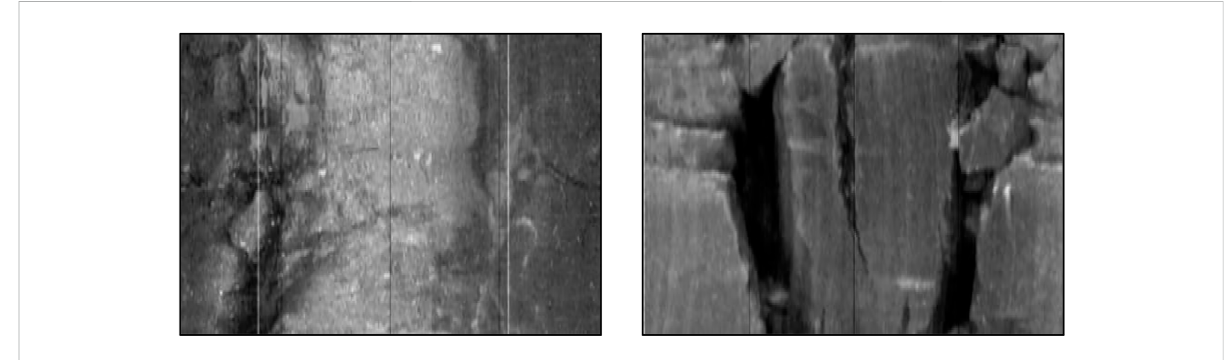
FIGURE 4 Borehole imaging of deep borehole wall